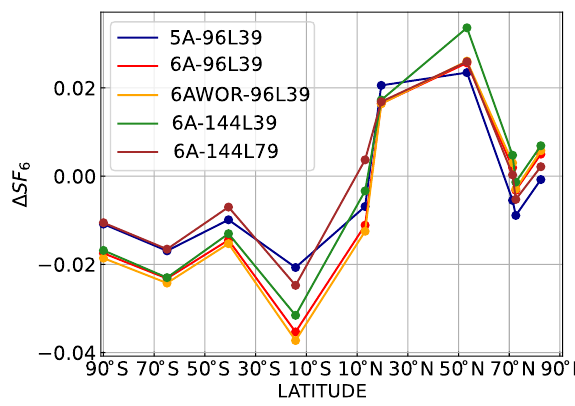
Figure 5. Latitudinal distribution of the SF 6 bias (modelled – ob- served) at the surface background stations during years 2005–2009. The stations used are: SPO, PSA, CGO, SMO, RPB, MLO, MHD, BRW, SUM, ALT.